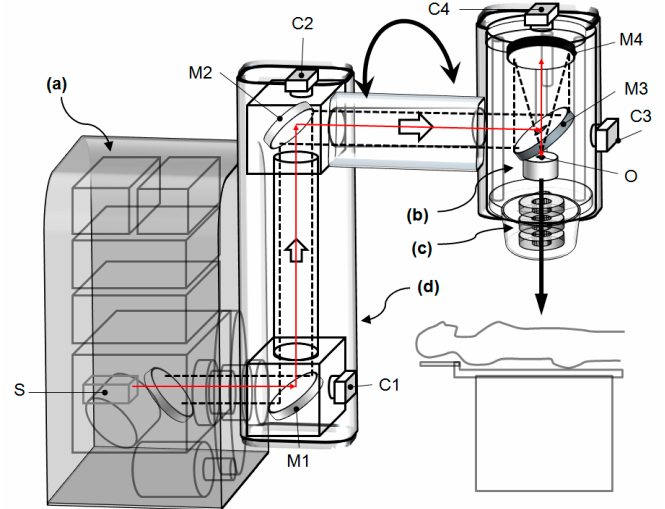
Figure 2. A conceptual sketch (not scaled) of the proposed radiation therapy system comprising ( a ) a drive laser system; ( b ) a laser plasma accelerator; ( c ) an electron beam focusing system; and ( d ) a laser-guiding vacuum transport embedded in a rotary